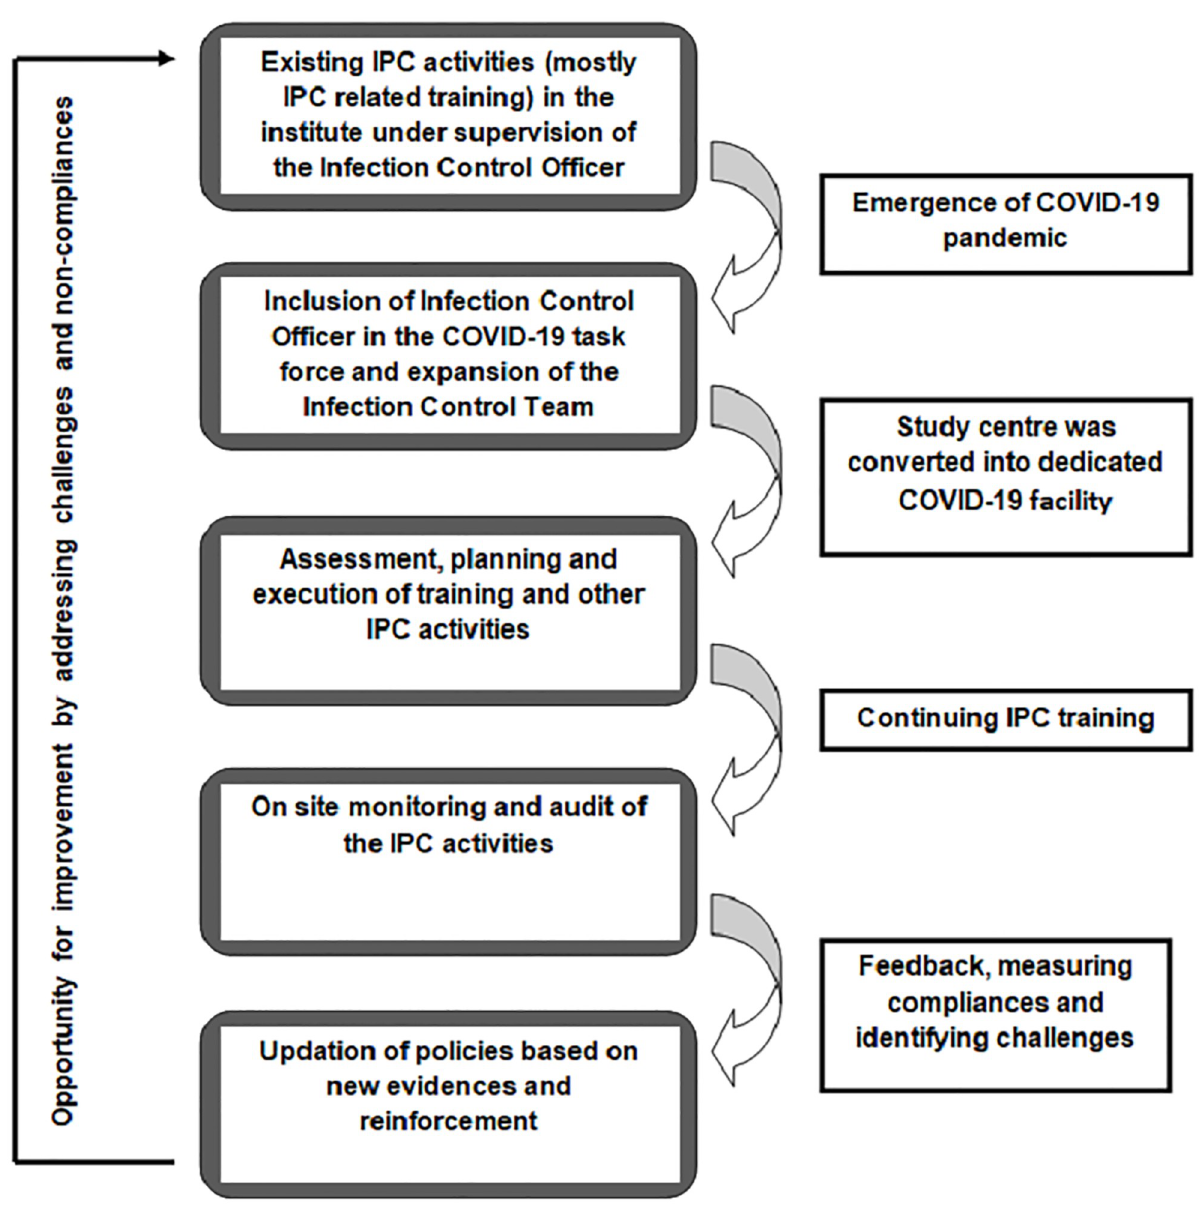
Fig 5. Summary of work conducted in the